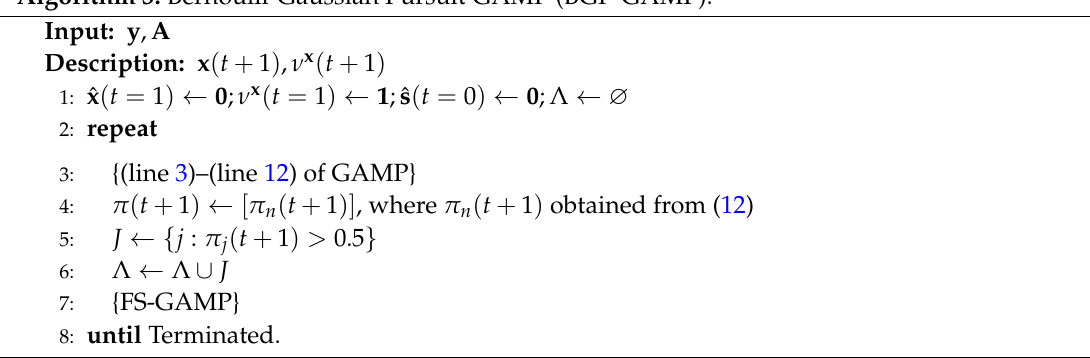
Algorithm 3: Bernoulli-Gaussian Pursuit GAMP